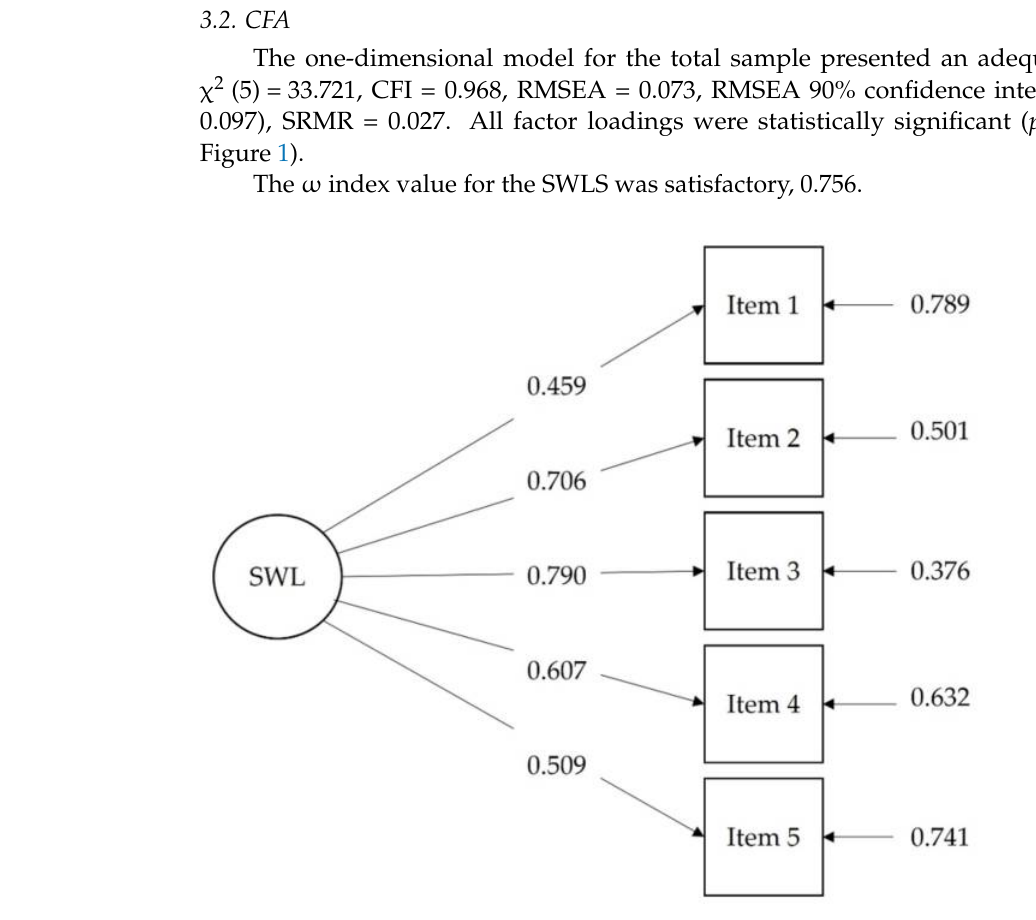
Figure 1. Path model for the Confirmatory Factor Analysis of the Satisfaction with Life Scale (SWLS), with factor loadings and residuals. Standardized coefficients are